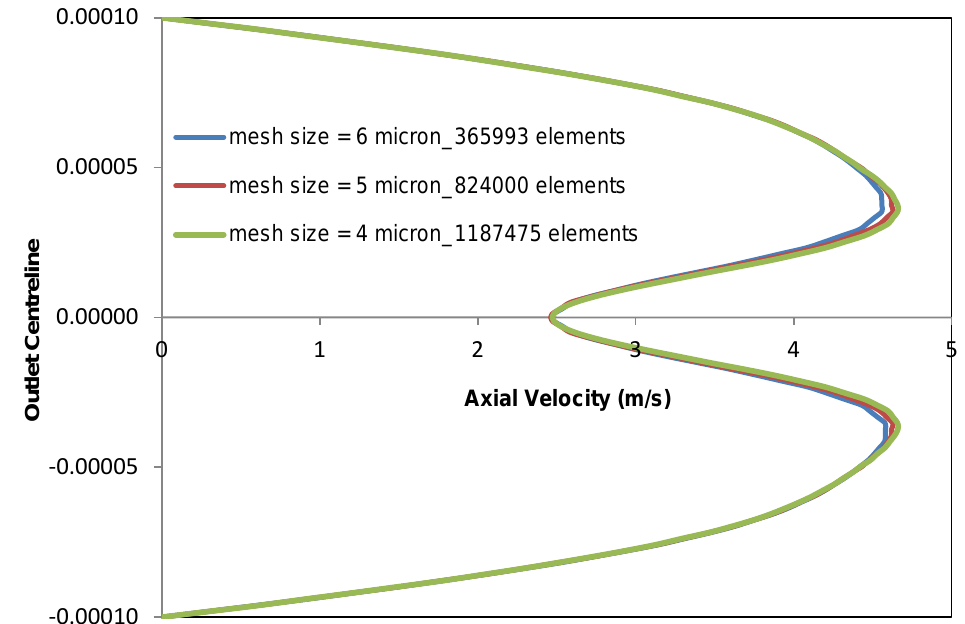
Figure 3. Axial velocity profiles on the outlet centreline of T-mixer with TDOs at Re =